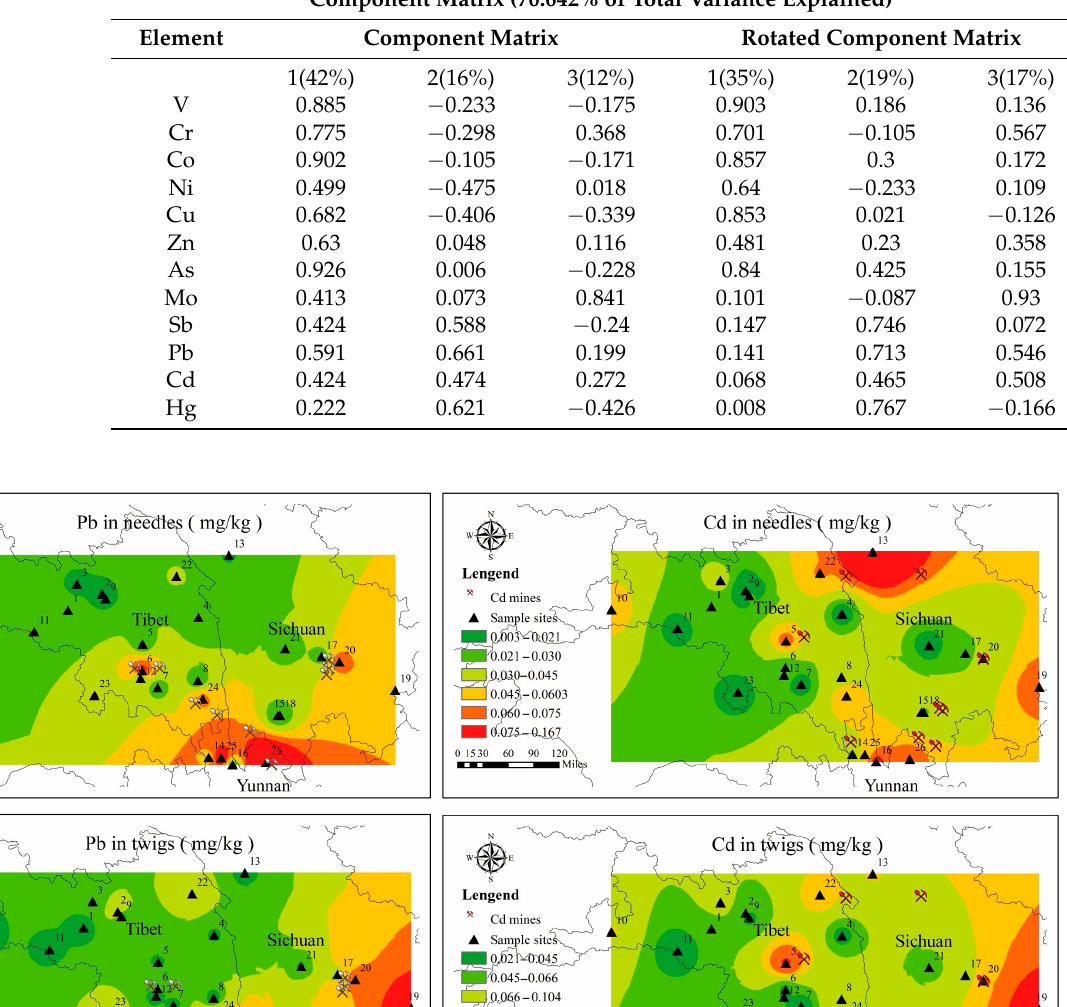
Figure 3. Pb and Cd in twigs and needles of different ages.